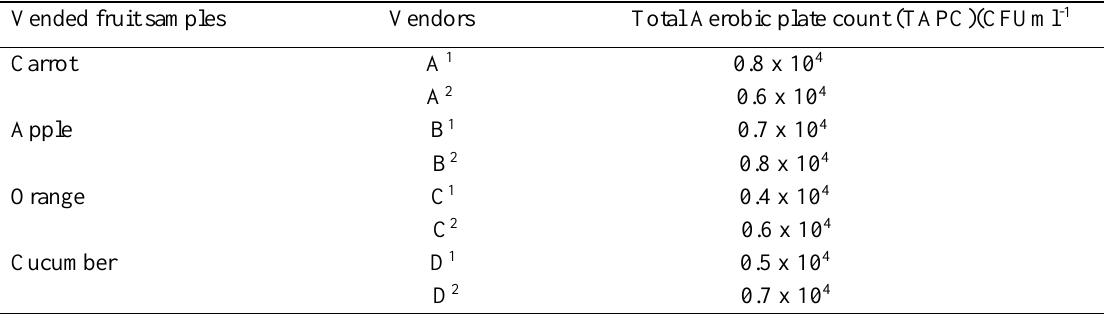
Table 1. Average microbial load of ready-to-eat vended fruit samples (CFU ml -1 ). Vended fruit